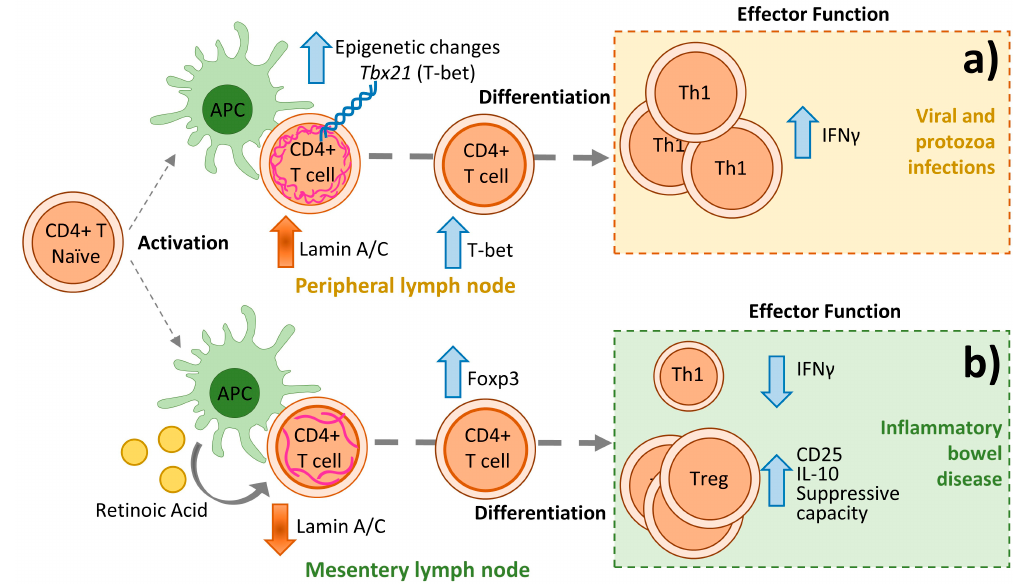
Figure 5. Lamin A / C in CD4 + T cells respectively promotes and inhibits the di ff erentiation and function of Th1 cells and Tregs. Upon antigen recognition, CD4 + T cells activate, proliferate, and di ff erentiate into specialized e ff ector T helper (Th) cells. ( a ) In the context of viral or protozoan infection, lamin A / C expression increases CD4 + T cell Th1 di ff erentiation by epigenetically regulating the mRNA expression of Tbx21 (T-bet). ( b ) In inflammatory bowel disease, the absence of lamin A / C in CD4 T cells enhances FOXP3 expression, which is reflected in increased Treg di ff erentiation and function, important in resolving the impaired Th1 response. Vertical arrows indicate changes in expression or function. The e ffi cacy of anti-tumor drugs depend on their capacity to induce apoptosis since apoptosis evasion is a redundant characteristic of cancer cells [223]. During apoptosis, the nuclear envelope is permeabilized by rupture of nuclear pore complex and nuclear lamina proteins, including lamin A / C [224]. Classical Hodgkin’s lymphoma is a kind of B cell lymphoma contained of Hodgkin and Reed-Sternberg cells with a unique or multiple nucleus, respectively [17]. Hodgkin and Reed-Sternberg cells show lamin A / C expression [33] and impaired lamin A / C structure, which is dissimilar from unstimulated common lymphocytes [17]. It has been described a caspase-dependent and independent [224] cleavage of lamin A / C, which dismantles the nuclear lamina, and promotes apoptosis in B cell lymphomas